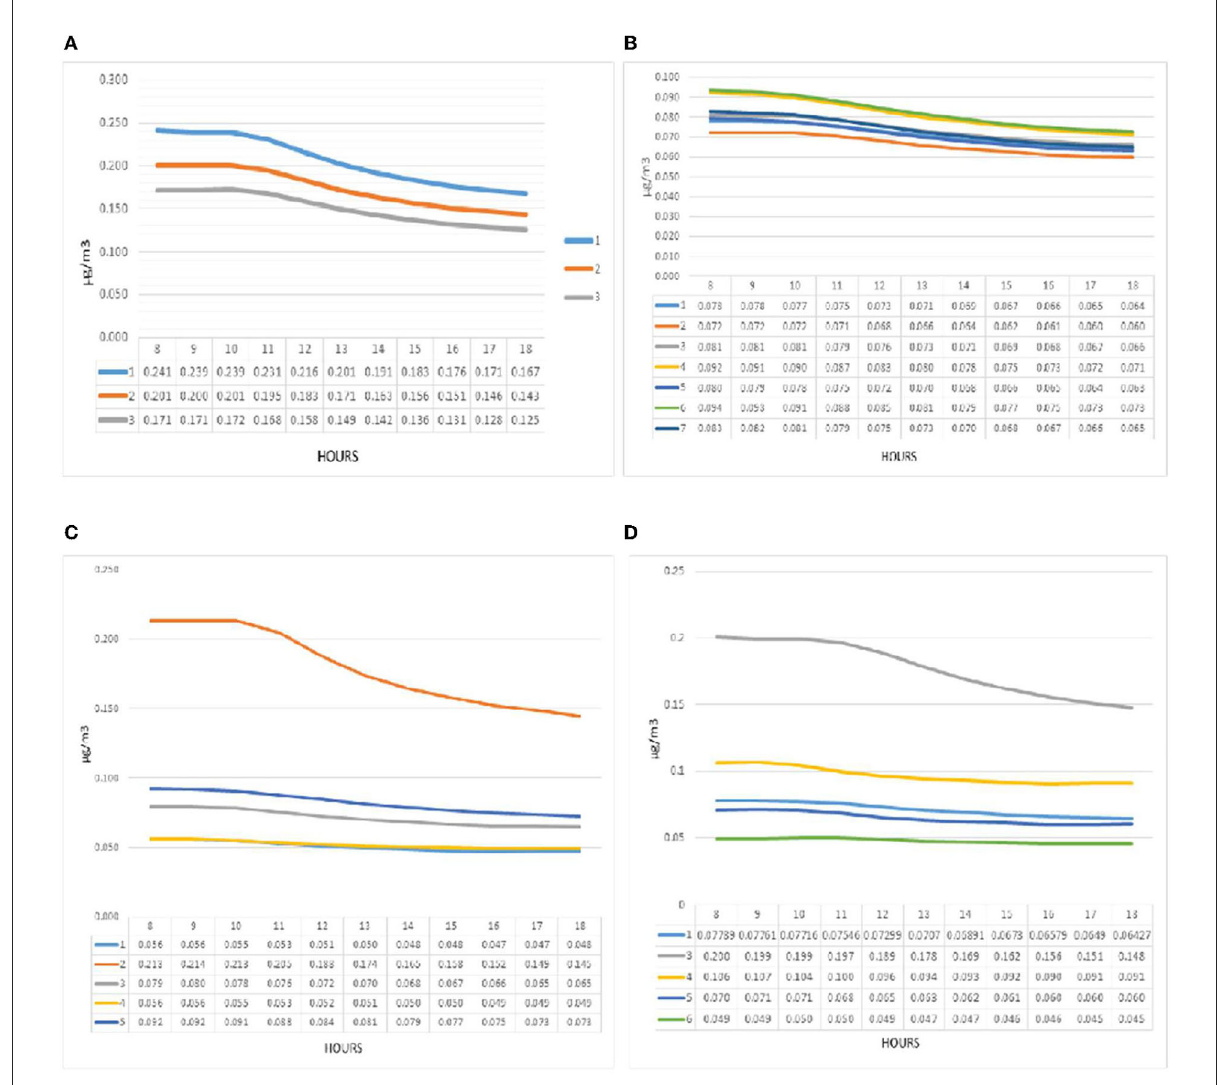
FIGURE8 (A–D) Pollution concentration diagrams from point A in all groups, respectively.